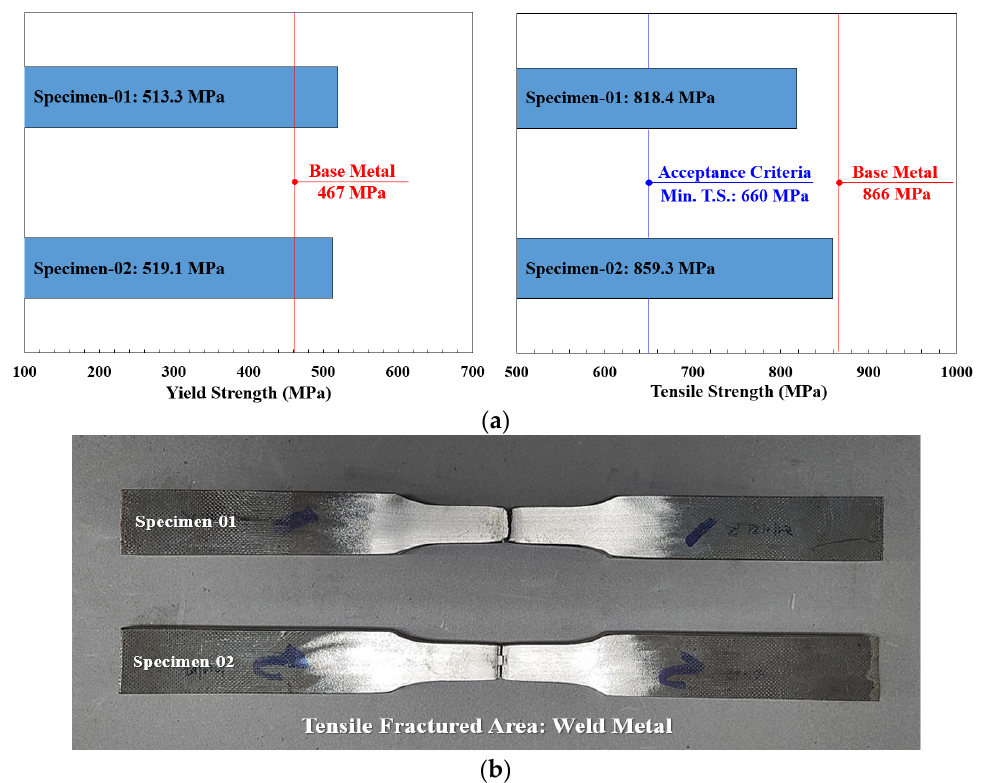
Figure 5. Results of the tensile test and the shape of the fracture specimen. ( a ) Yield-tensile strength of the laser-MIG hybrid welded joints, ( b ) shape of the fracture specimen after the tensile test.